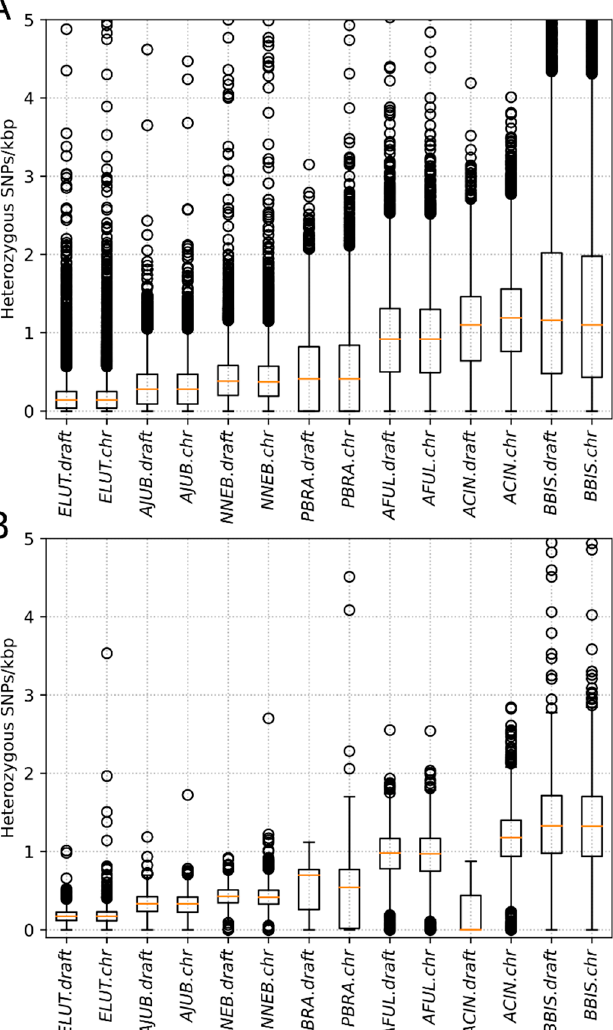
Figure 3. Comparison of the distributions of mean heterozygosity in ( A ) windows of 100 kbp and ( B ) windows of 1 Mbp for the short-read assembled draft genomes and the chromosome-level assemblies. The codes in the Figure are: ELUT—sea otter ( Enhydra lutris ), AJUB—cheetah ( Acinonyx jubatus ), NNEB—clouded leopard ( Neofelis nebulosa ), PBRA—giant otter ( Pteronura brasiliensis ), AFUL—red panda ( Ailurus fulgens ), ACIN—Asian small-clawed otter ( Aonyx cinereus ), and BBIS—American bison ( Bison bison ).